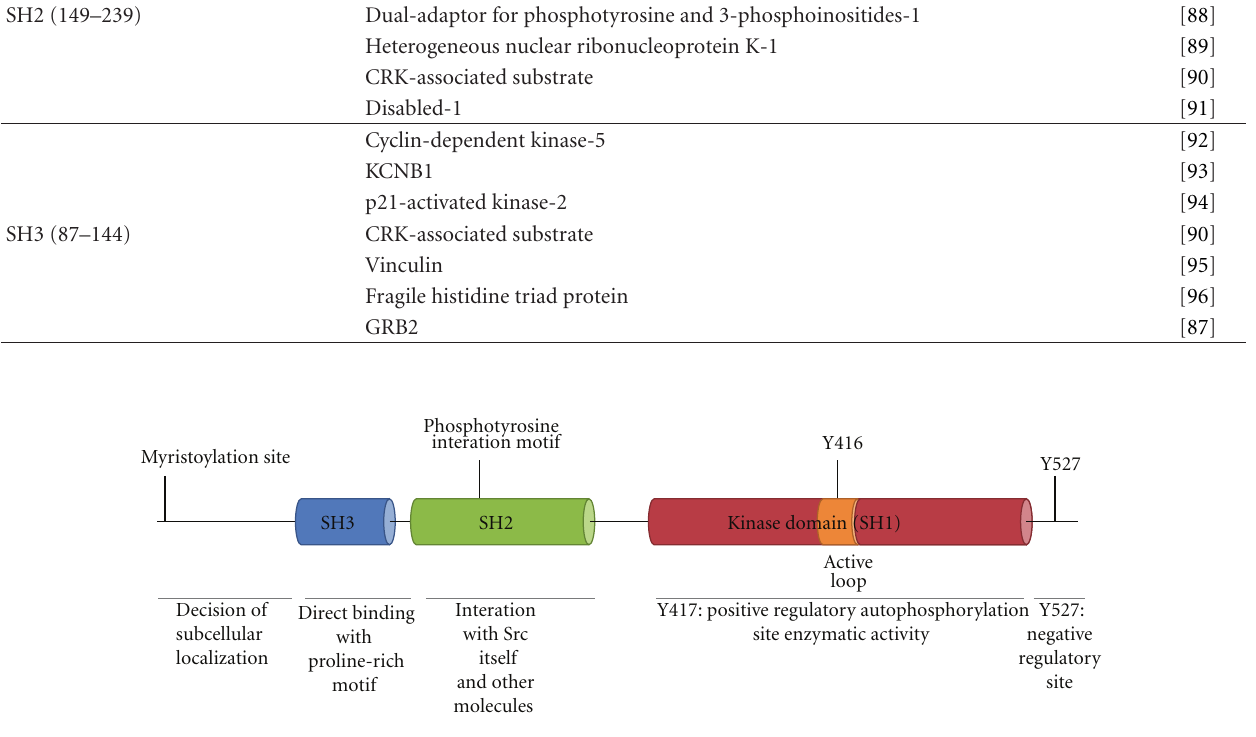
Figure 1: The structure of